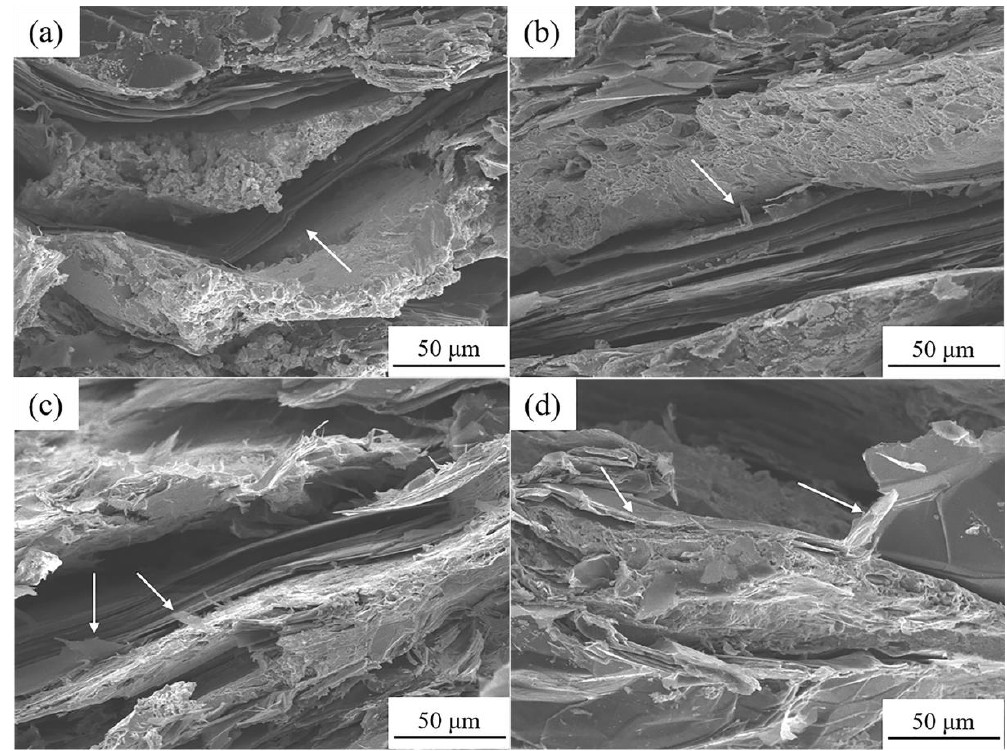
10 of 14 Figure 12. Bending strength of FG/Cu composites with different Zr contents. Figure 13 shows the fracture morphology of the FG/Cu composites with different Zr contents. It can be found that the FGs are detached from the Cu matrix and accompanied by fragmentation phenomena in the FG/Cu-0Zr composite as seen in Figure 13a. However, graphitic layers near the Cu matrix peel off, and the part far from the matrix is still intact in the FG/Cu composites with 0.5 wt % and 1 wt % Zr as seen in Figure 13b,c. With 2 wt % Zr (Figure 13d), the graphite crystal near the Cu-